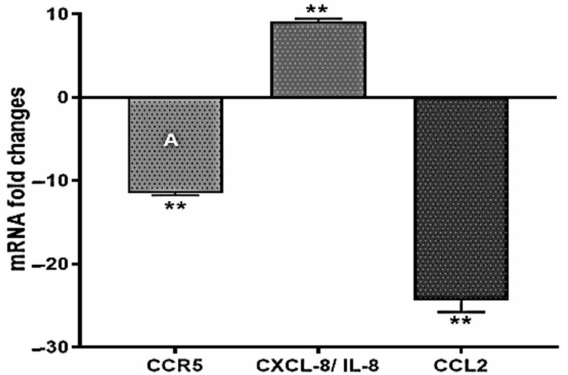
Figure 6. CCR5, CXCL8 (IL-8), and CCL2 mRNA fold-change following a 24 h co-culture of ST285 with monocytes ( n = 3), compared to control monocytes. The innate and adaptive RT 2 gene profiler arrays were used to determine changes in gene expression. The symbol represents the p -value for Tukey’s test (one-way ANOVA) where ** p < 0.04.